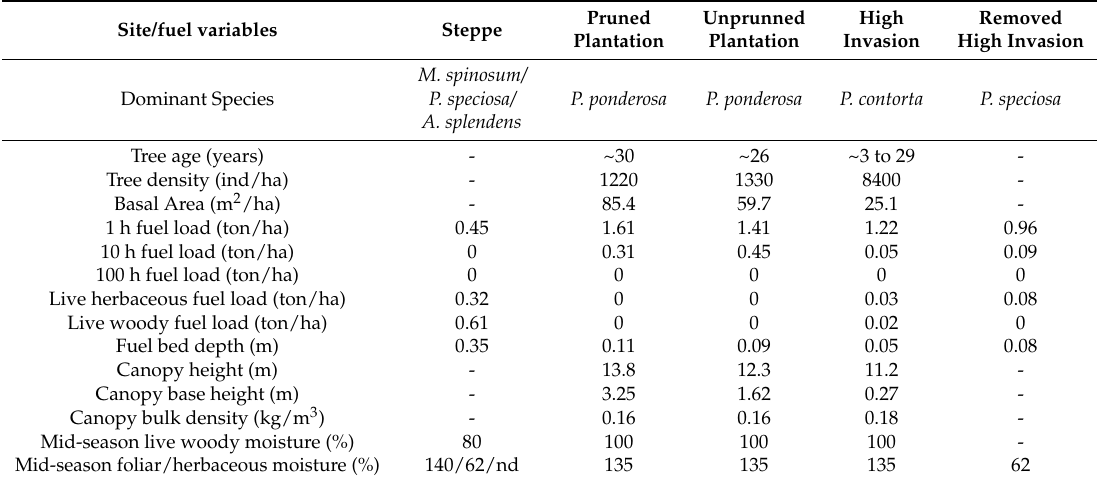
Table 2. Description of the five selected treatments sampled for constructing the fuel models to simulate fire behavior. Fuel load values correspond to surface fuels only (<2 m height). nd: no